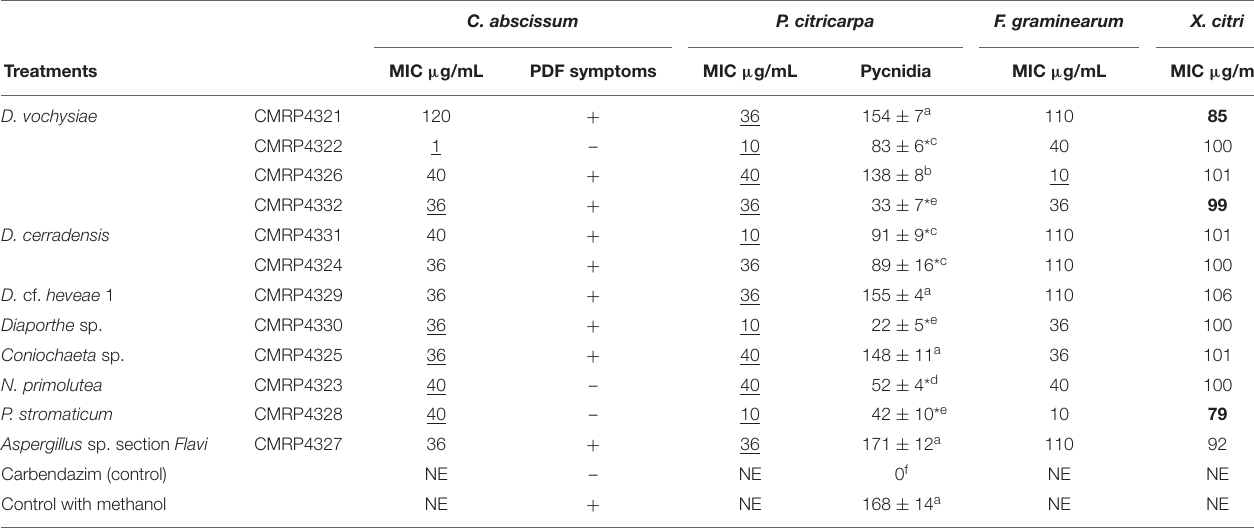
TABLE 1 | Minimum inhibitory concentration ( µ g/mL) of extracts produced by the endophytes against the pathogens Colletotrichum abscissum, Phyllosticta citricarpa , Fusarium graminearum, and Xanthomonas citri subsp. citri (in bold extracts with bactericidal activity), post-bloom fruit drop (PFD) symptoms in the presence of extracts and number of pycnidia produced in leaves by P. citricarpa in the presence of extracts.